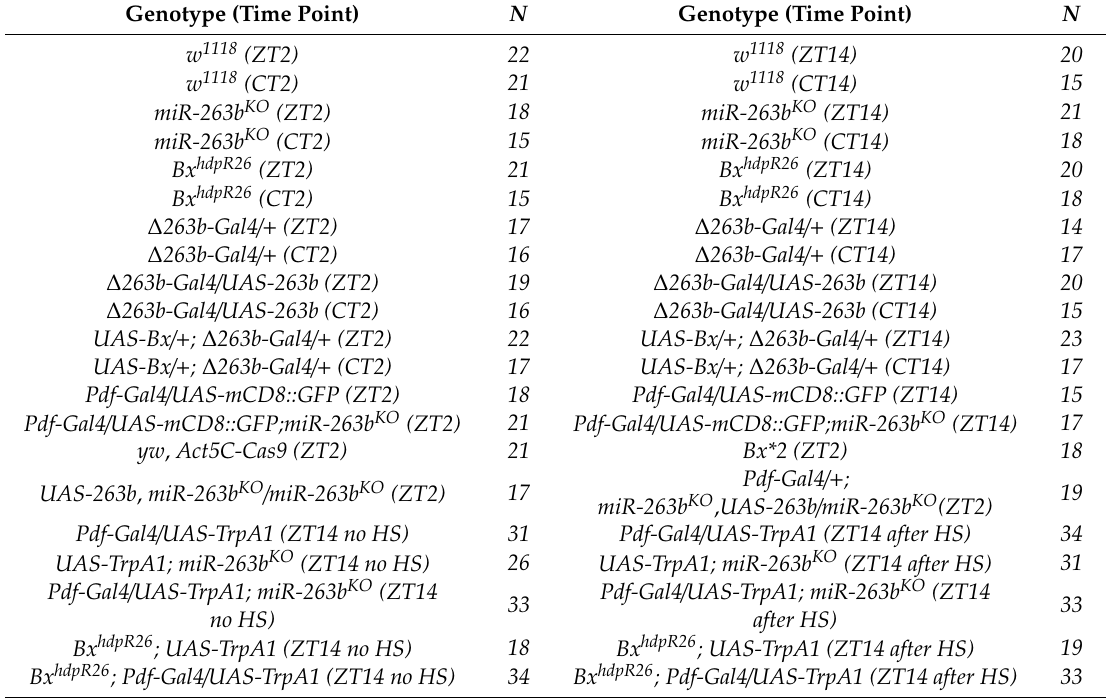
Table 2. The fly genotypes for analysis of activity-dependent changes in axonal morphology. ZT—Zeitgeber time; CT—circadian